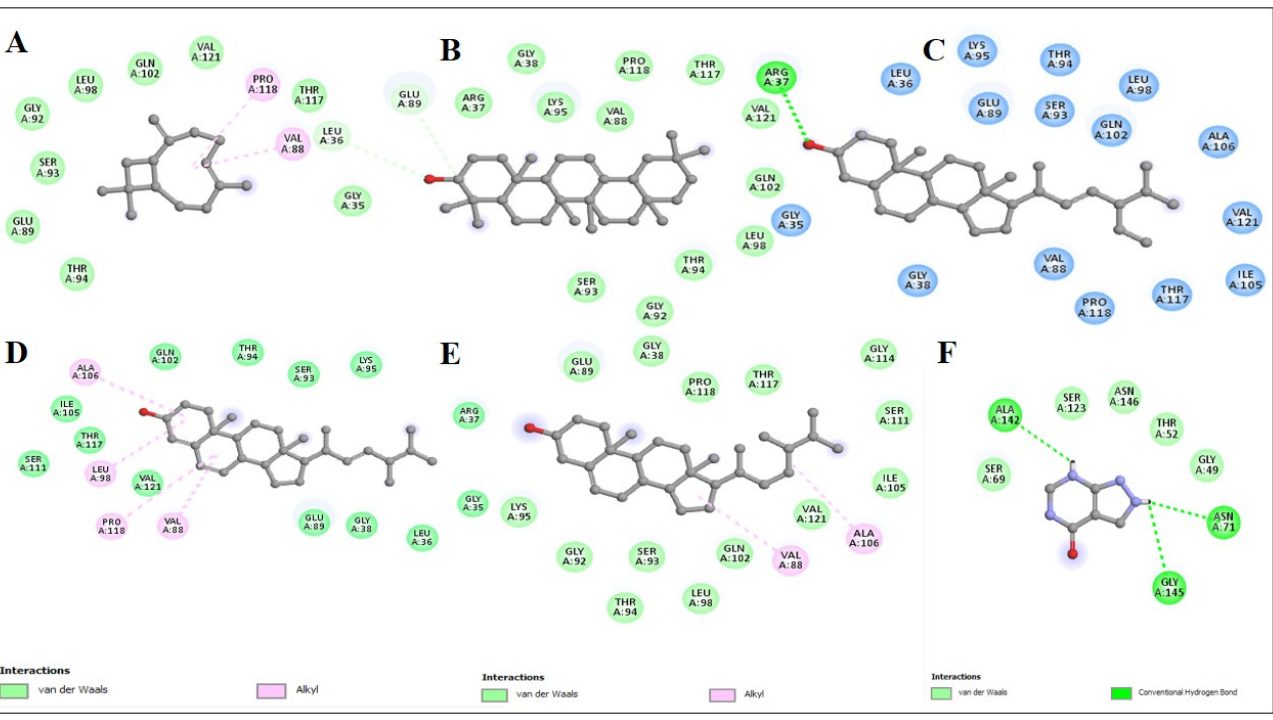
Figure 4. Molecular docking of selected ligands with xanthine oxidase enzyme.